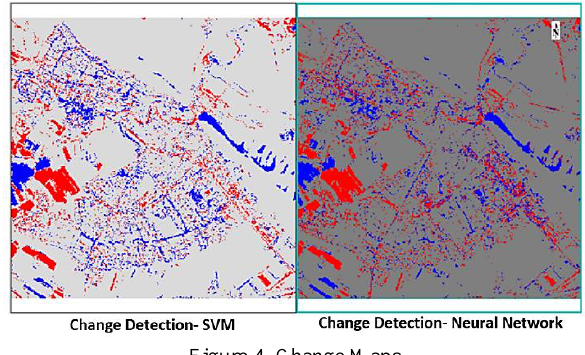
Table 2. Confusion Matrix for SVM Classification